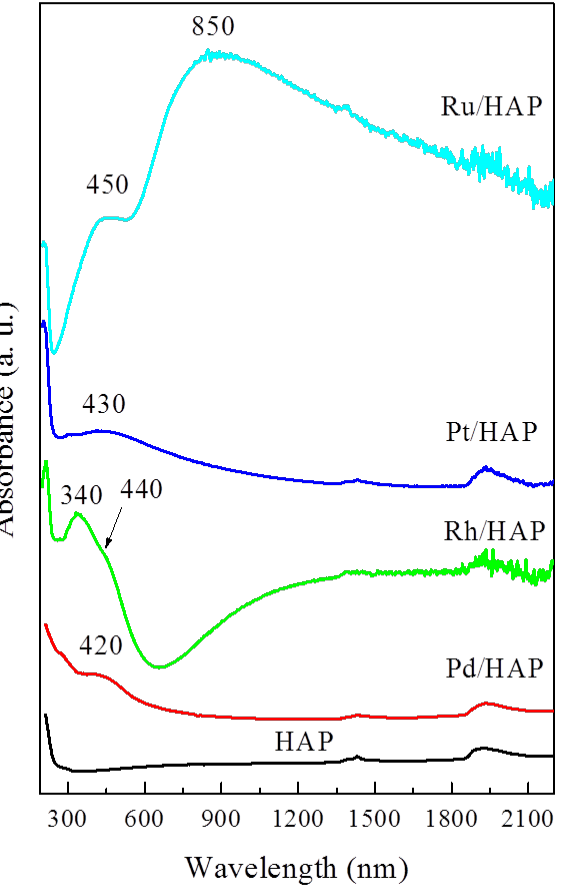
Figure 2. UV-Vis-NIR spectra for the noble metal catalysts.